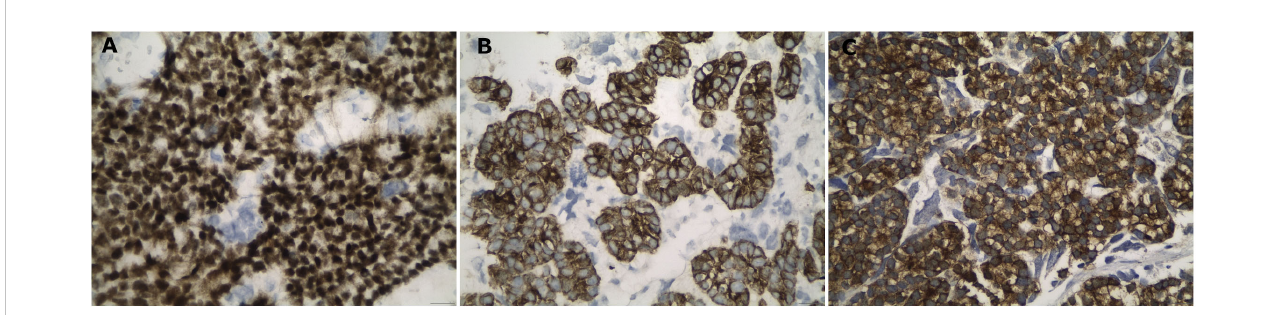
FIGURE 3 High power views of the histological images, showing strong nuclear positivity for TLE-1 (A) , strong positivity against pancytokeratin (B) and, fi nally, strong immunoreactivity for thyroglobulin proving the origin from the thyroid gland (C) . Immunohistochemical peroxidase staining, diaminobenzidine as